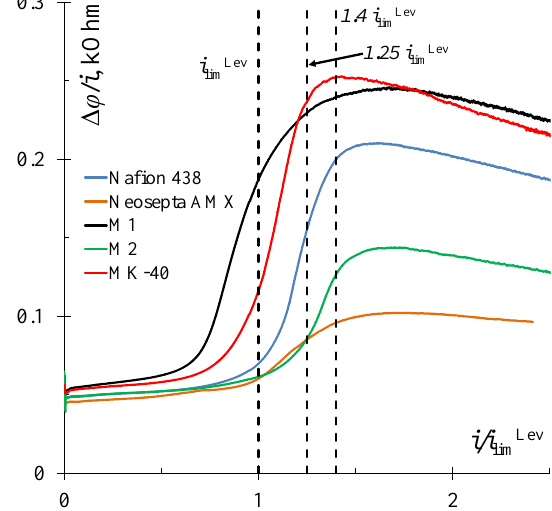
Figure 8. Resistance ( ∆ φ / i ) versus i / i limLev dependencies for the studied membranes determined from current–voltage curves (Figure 5).